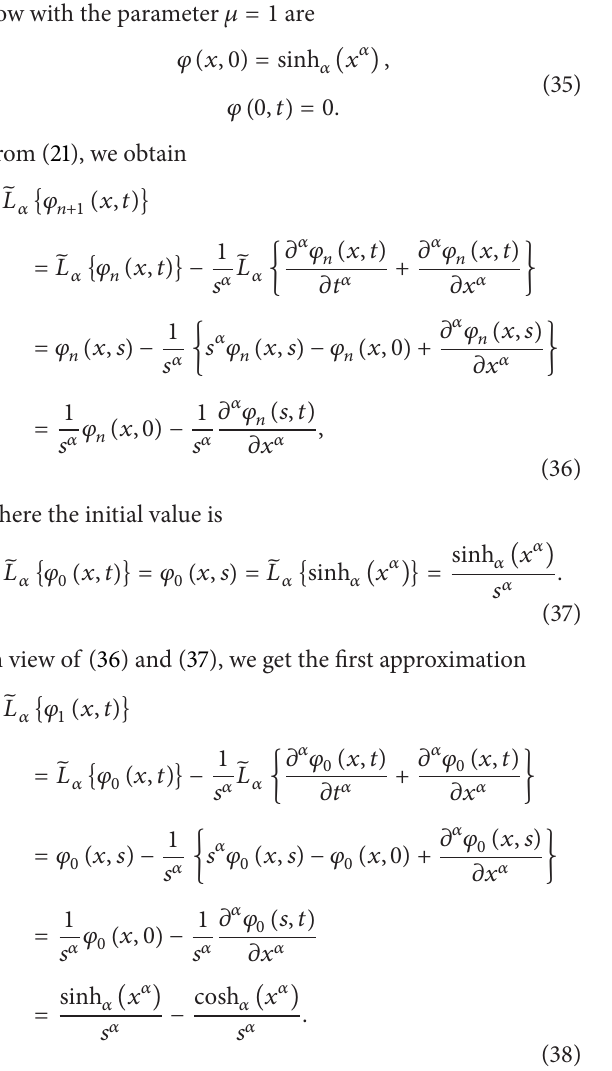
Example 2. The initial and boundary conditions for